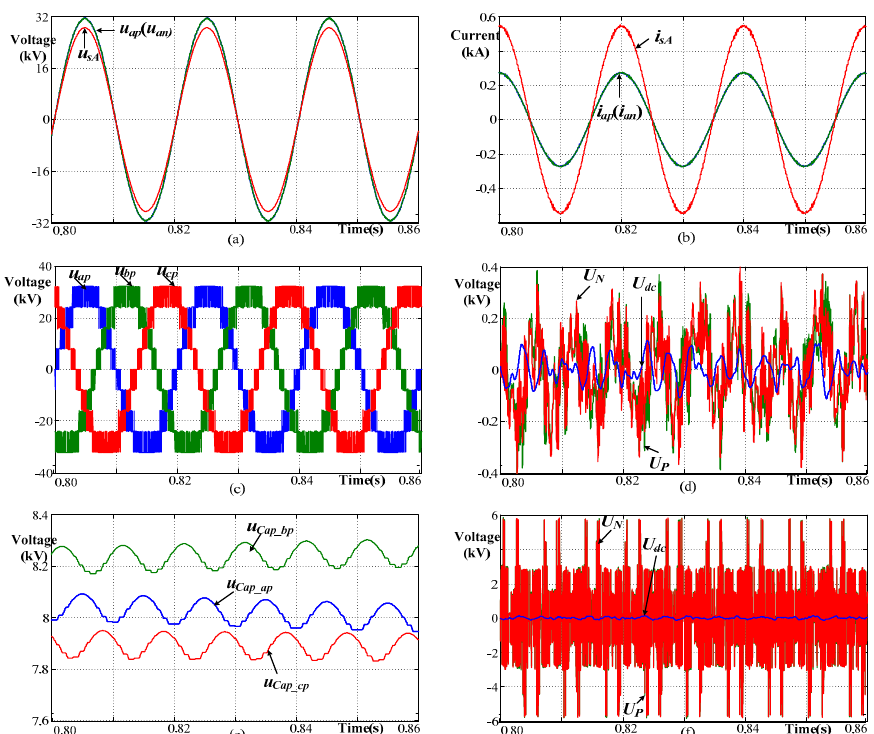
Figure 5. Simulation results of dual-SVGs system. ( a ) arm voltage (fileted high frequency ripple), ( b ) arm current, ( c ) arm voltage (unfiltered), ( d ) DC-side voltage (fileted high frequency ripple), ( e ) capacitor voltage of the first submodule in upper three arms, ( f ) original DC-side voltage (unfiltered).